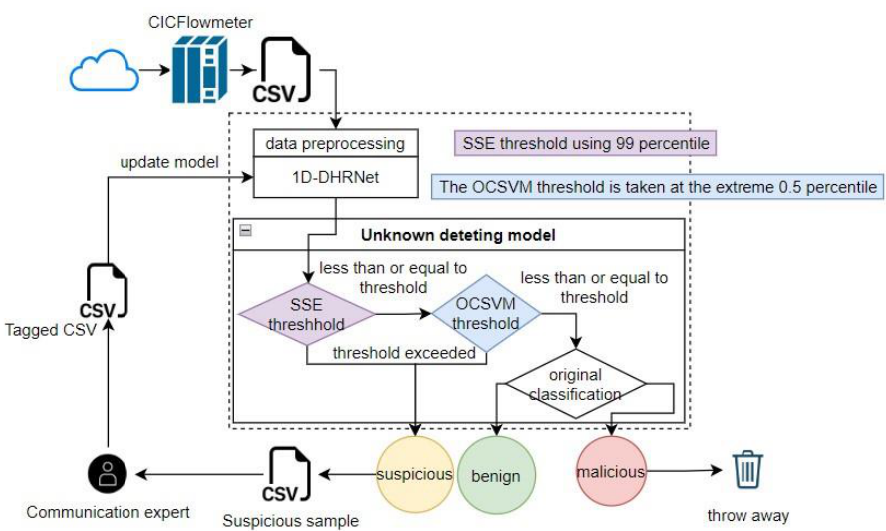
Figure 1. Proposed framework architecture.